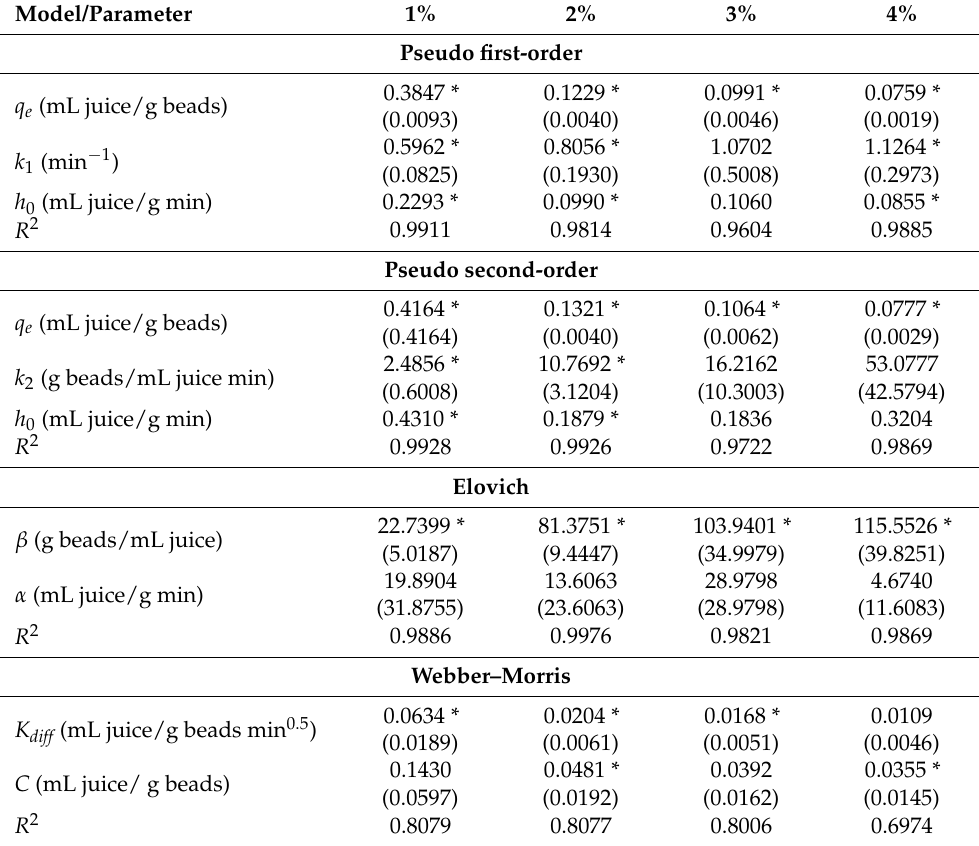
parameters estimates. Values with an asterisk (*) represent significant values at p <